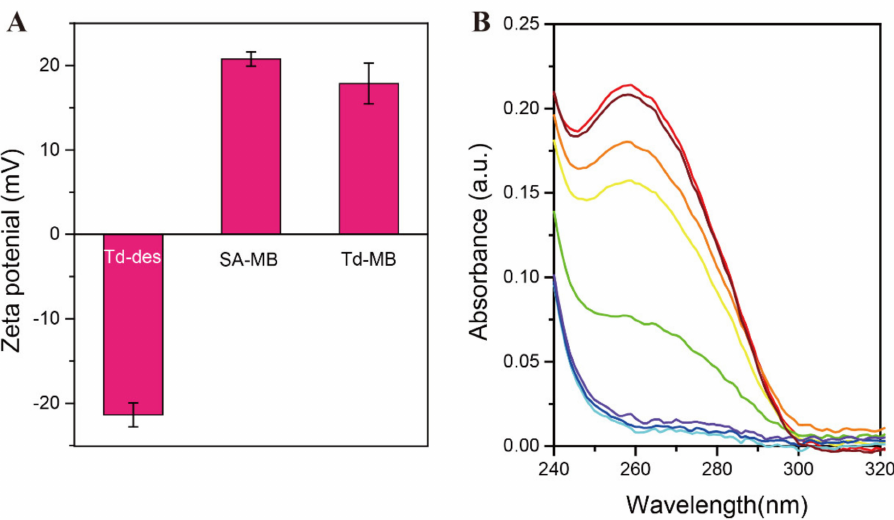
Figure 4. Verification and optimization of Td − MBs. ( A ) Zeta potential histogram of Td − des, SA − MB, and Td − MB; ( B ) UV/Vis spectra of Td1 upon addition of a different volume of MBs. The concentration of each line from top to bottom was 0 µ L, 5 µ L, 10 µ L,20 µ L, 50 µ L, 75 µ L, 150 µ L, 200 µ L, 300 µ